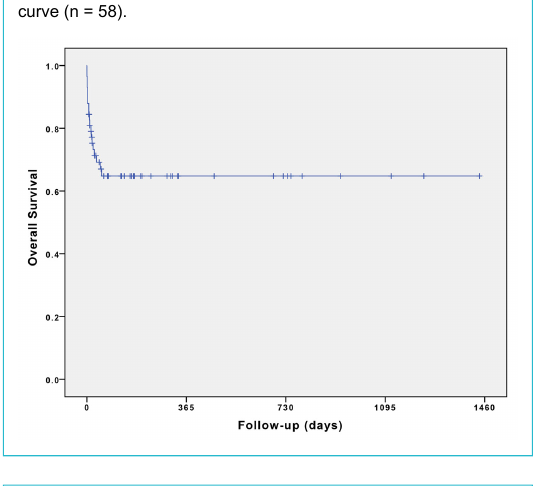
Figure 2E: Kaplan-Meier cumulative survival curves grouped by means of transport: blue graph helicopter (n = 35) and green graph ambulance (n = 23). Log-rank (Mantel Cox) test: p =